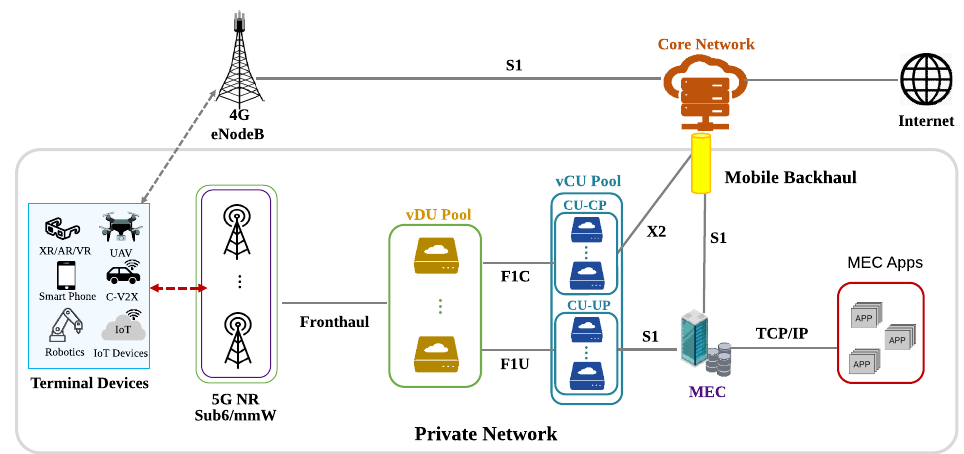
Figure 4. Network Architecture of Private/Local Telecom Operator.